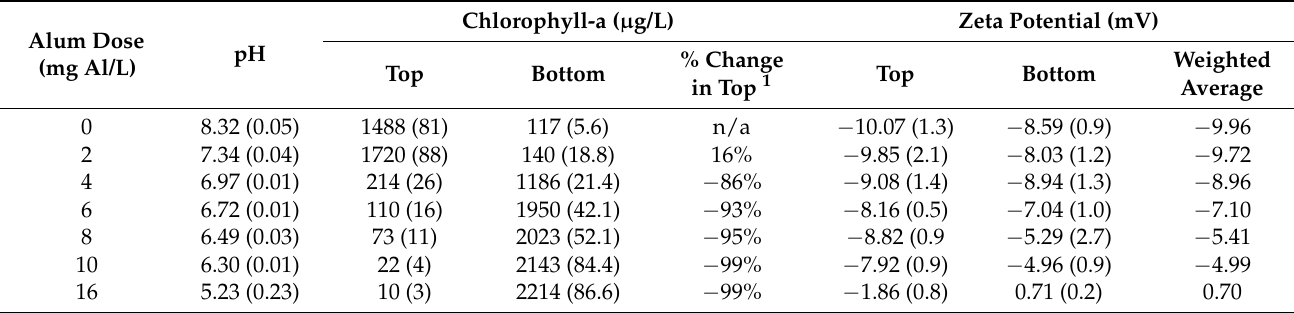
Table 2. pH, chlorophyll-a (micrograms per liter), and zeta potential (mV) in the samples collected from the top and bottom of the experimental units following dosing with coagulant (aluminum sulfate, alum, in mg Al/L) only. The mean ( n = 3) and standard deviation (SD) of the initial chlorophyll-a concentration and pH of the lake water were 403 (26) µ g/L and 8.32 (0.05), respectively. The mean ( n = 3) and SD (in parentheses) for the parameters measured from experimentation are reported below. The weighted average zeta potential was computed using chlorophyll-a for